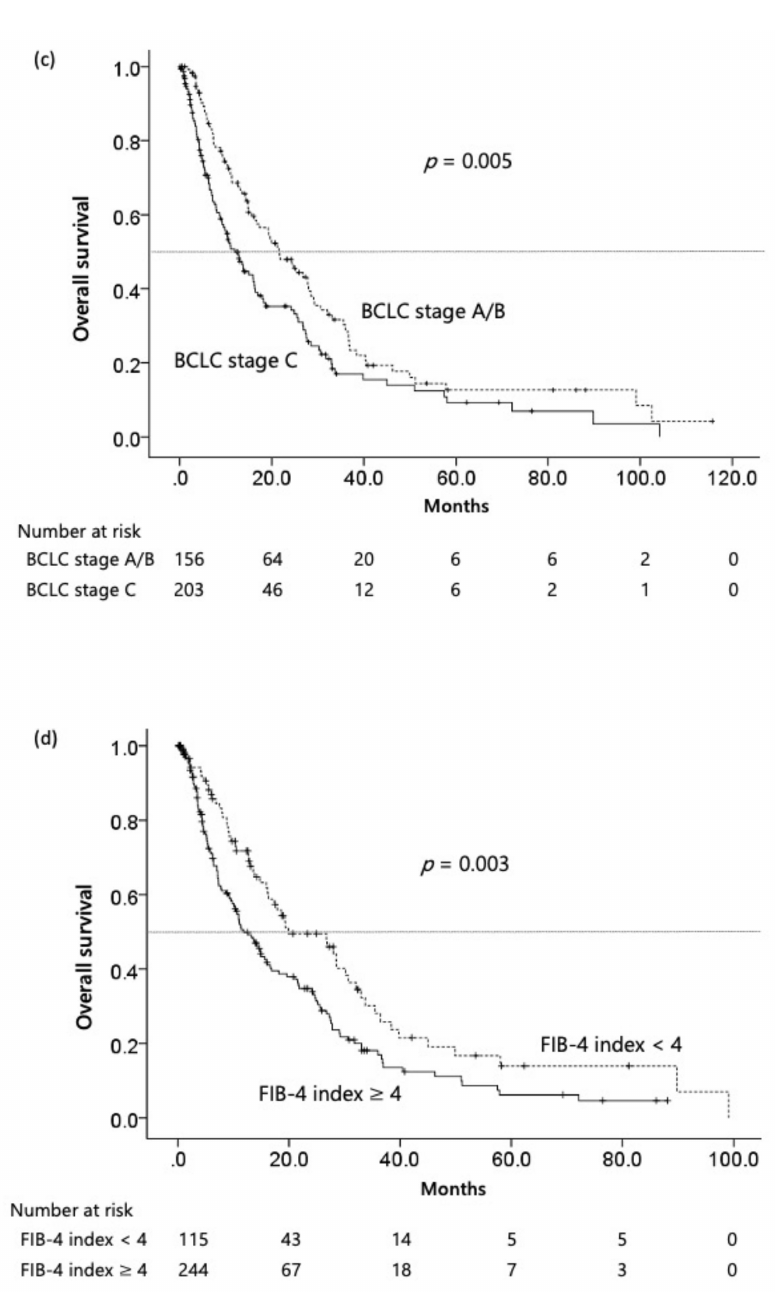
Figure 2. Kaplan–Meier curves of OS in HCV-related HCC patients treated with first-line molecular targeted therapies. ( a ) SVR vs. HCV viremia; ( b ) ALBI grade I and II vs. III; ( c ) BCLC stage I/II vs. III; ( d ) FIB-4 index < 4 vs. ≥